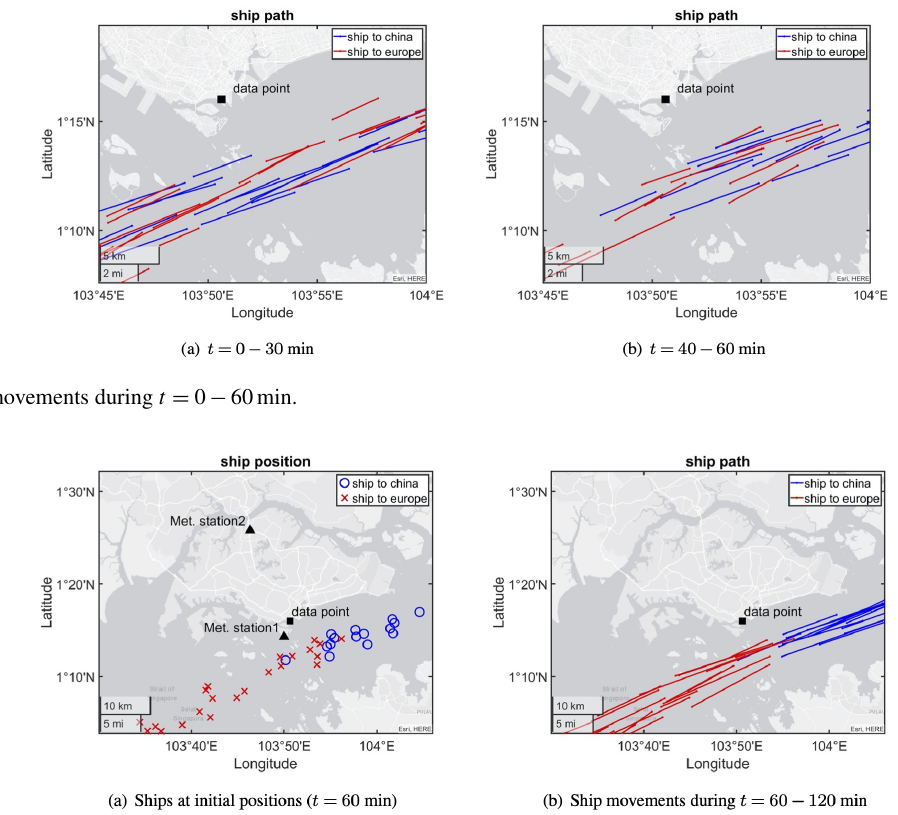
Figure 12. The ship initial positions and movements during t =